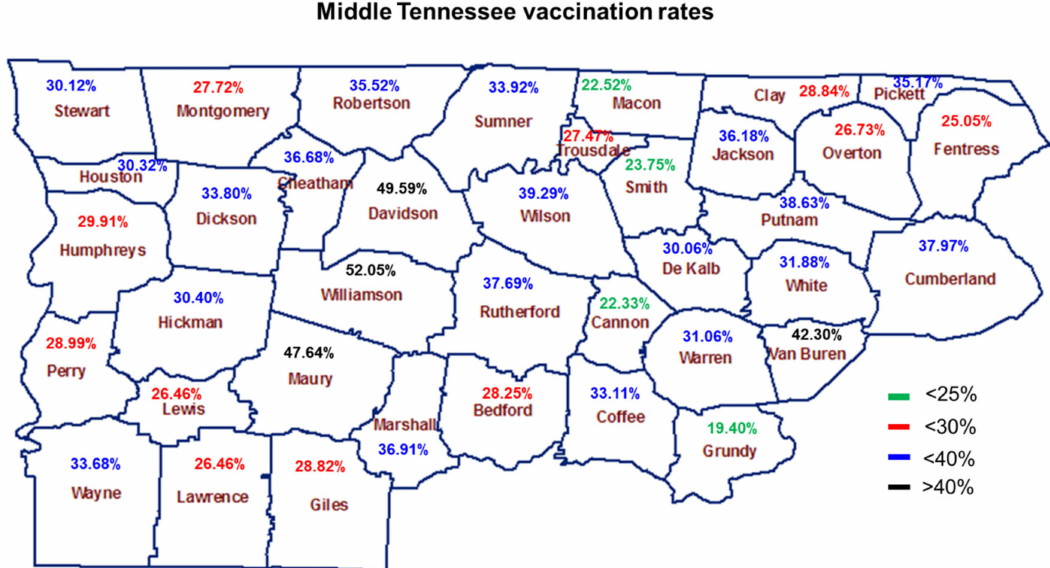
Figure 5. Vaccination rates for the 38 counties in Middle Tennessee as of 18 July 2021. Counties in Middle Tennessee are labeled in brown text. Vaccination rates < 25% are shown in green text, vaccination rates < 30% are shown in red text, vaccina- tion rates < 40% are shown in blue text, and vaccination rates > 40% are shown in black text. Vaccination rates were obtained from the Tennessee Department of Health https://www.tn.gov/health/cedep/ncov/data.html (accessed on 11 July